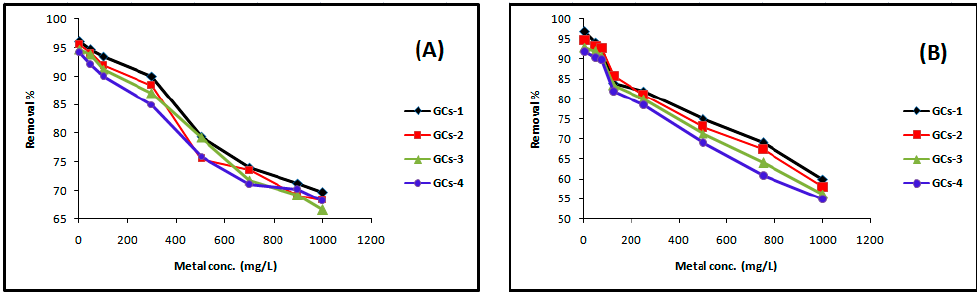
Figure 6. Influence of the initial concentration on ( A ) nickel and ( B ) copper sorption.